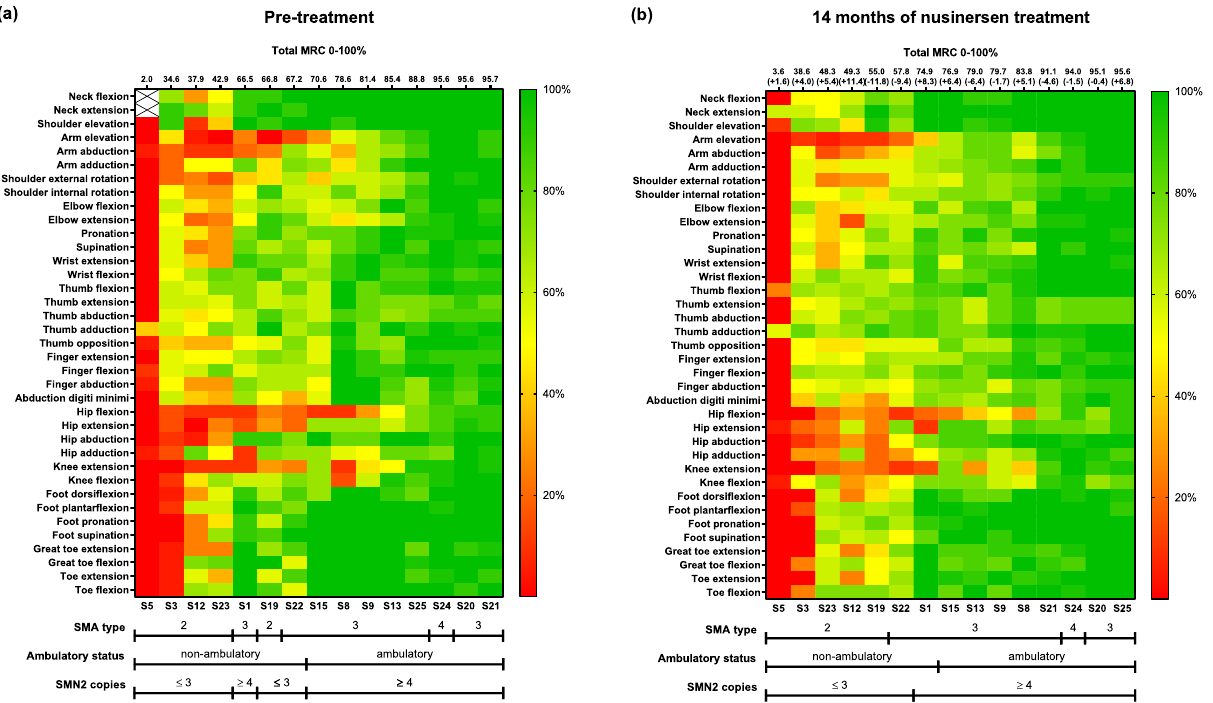
Figure 1. Muscle function patterns of 15 assessed patients with SMA types 2–4. Individual values are presented as the mean of both sides (with the exception of neck flexion und extension) and sorted by maximum total MRC % at baseline ( a ) or month 14 ( b ). Patients are represented by columns on the x-axis. Patients with minor muscle strength grouped on the far left. Columns on the y-axis represent the impairment pattern of specific muscle functions through the study population. Green (100%) corresponds to the absence of muscle weakness and red (0%) to plegia. Lines underneath the heatmaps indicate the corresponding distribution of SMA subtypes, ambulatory status and SMN2 copies. ( a ) The impairment pattern at baseline shows a main involvement of proximal muscles, while distal muscle weakness was only visible in more progressed patients. ( b ) After 14 months on treatment, a trend towards regaining proximal muscle strength was seen, predominantly in the upper limbs.